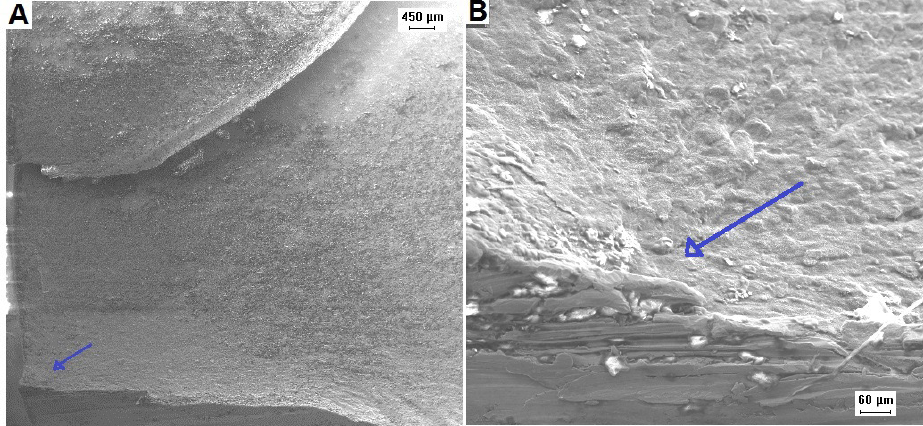
Figure 13. SEM images of the fracture surface of the P2 blade. (A) Crack propagation planes, as shown in Figure 11A , and the fracture progression lines, it was possible to locate the nucleation site of the main crack (blue arrow). (B) Detail of previous image evidencing the crack